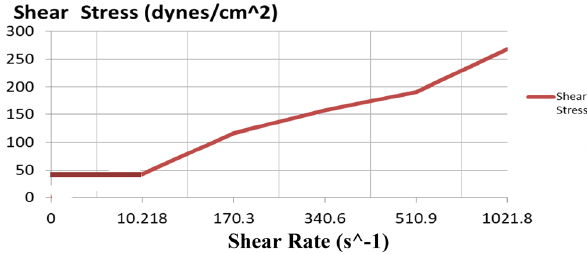
Fig. 32 Shear stress vs shear rate of optimized PHPA–bentonite mud